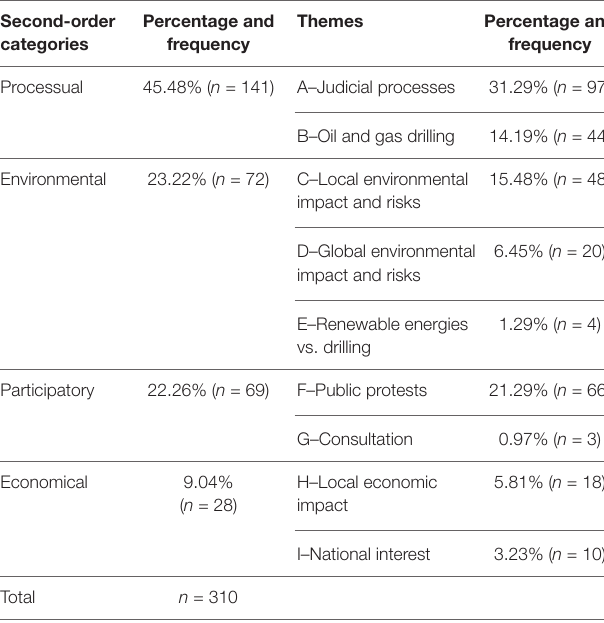
TABLE 2 | Frequency of actors in the studied